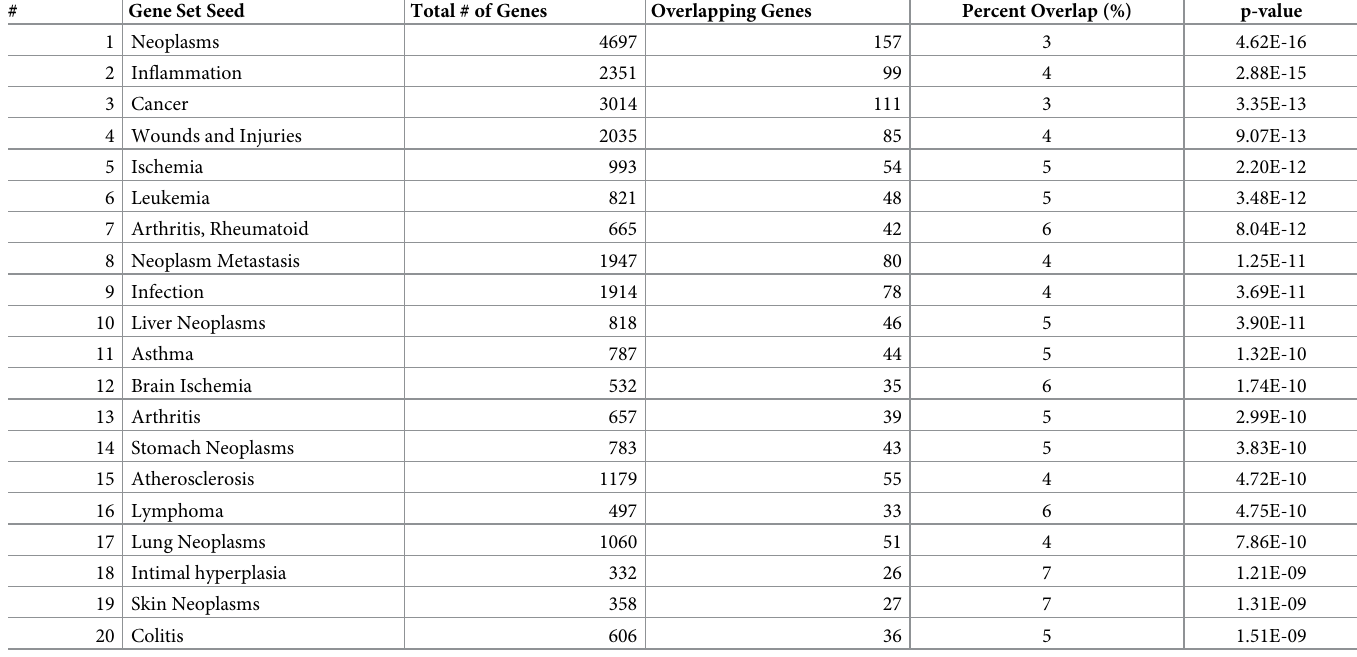
Table 5. Disease pathway analysis of differentially expressed genes in red tide and control Florida manatees selected by subnetwork enrichment. The number of overlapping genes between the two groups, percentage overlap, and significance of overlap (p-value) are